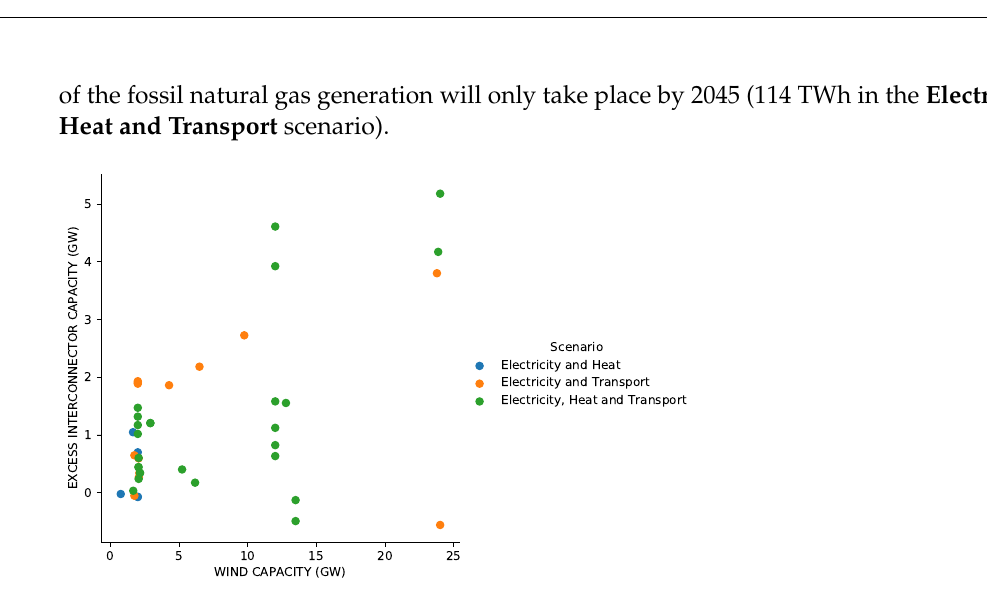
Figure 12. Excess interconnector capacity versus installed wind capacity in each hub in all stud- ied years per scenario. Excess interconnector capacity is calculated as the difference between the aggregated electricity interconnector capacity of each hub and the installed wind capacity at the hub.